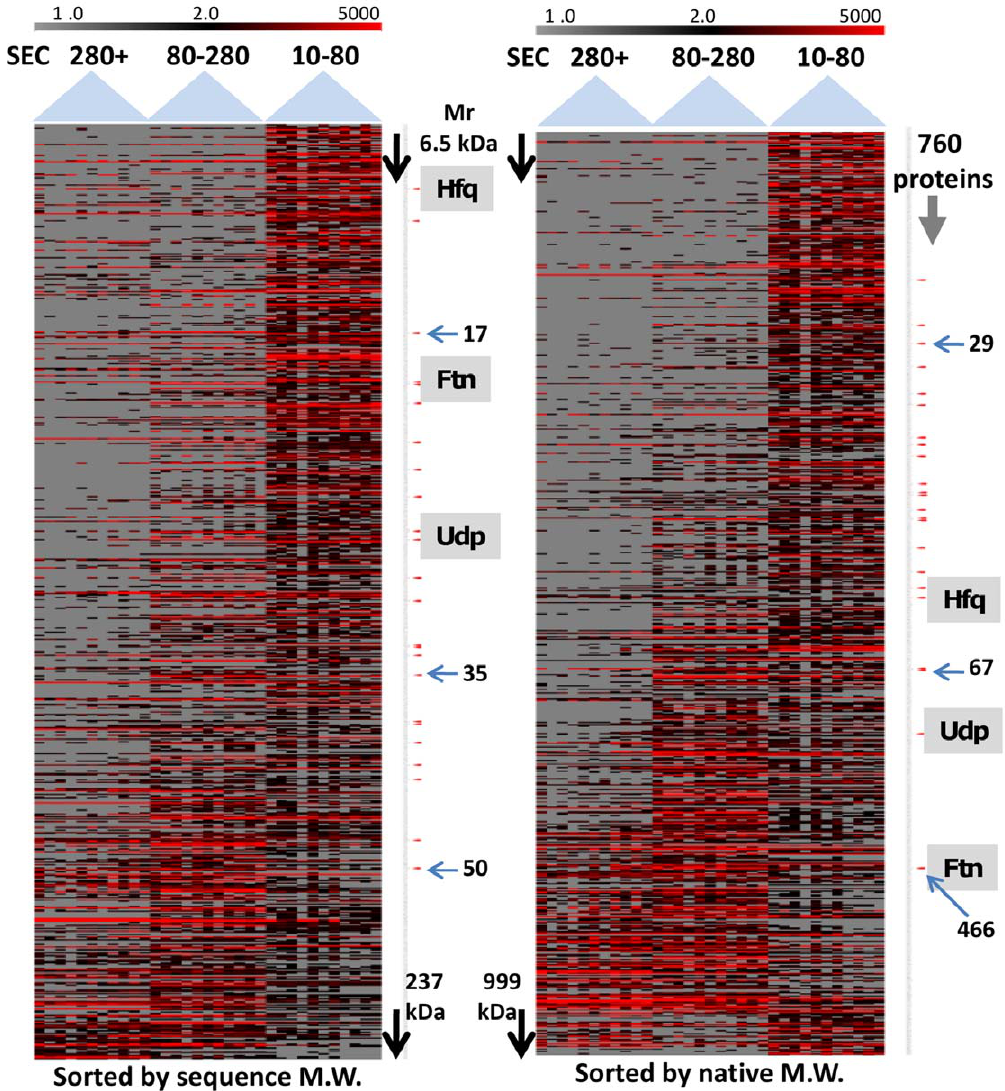
Figure 3. Correlation of native and sequence-based M r values of proteins with their quantitative elution profiles in SEC fractions associated with three approximate M r ranges (F1-s SEC , . 280 kDa, F2-s SEC 280-80 kDa, F3-s SEC 80-10 kDa). Each heat map column under the broad blue arrow indicating a M r range represents 11 individual, replicate APEX i datasets. Each row corresponds to one of 760 EHEC proteins, quantified with the APEX i tool, that were altered with statistical significance using the Kruskal-Wallis test (p-value , 0.02) comparing protein abundances in the three SEC fractions (F1-s SEC , F2-s SEC and F3-s SEC ). The range of colors in the heat map corresponds to APEX i values from 0 to 5000. Left heap map: proteins are ordered based on calculated, amino acid sequence-based M r values; right heat map: proteins are ordered based on native M r values including homooligomers and multi-protein complexes (for calculations, see Table S7 ). The maximum M r value was 999 kDa, including larger complexes such as the ribosome. Protein positions are indicated for the monomer/complex as follows: Ftn/Ftn 24 , Udp/Udp 6 and Hfq/Hfq 6 . The correlation of protein elution patterns by SEC with calculated native M r s is improved.